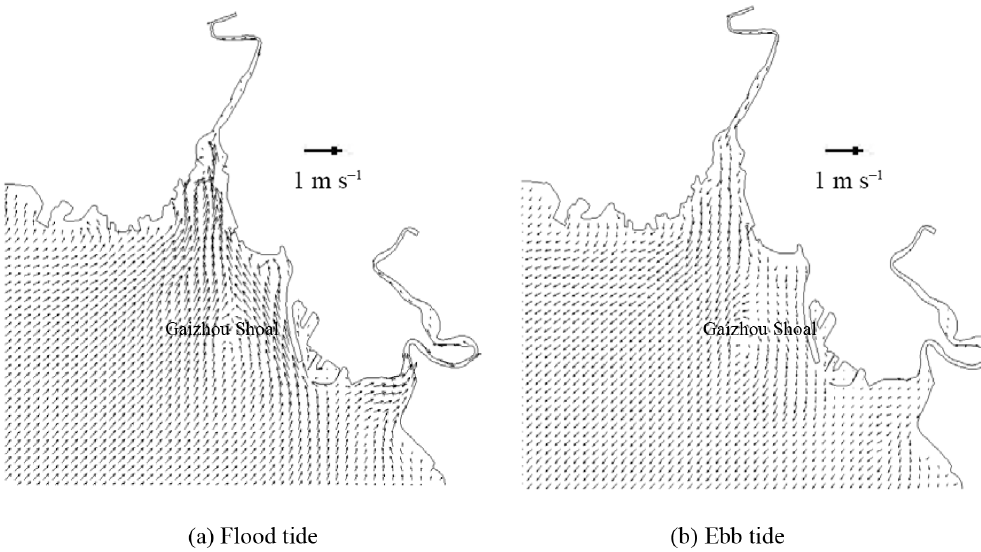
Figure 8. Flow field during spring tide, interpolated to a regular grid for